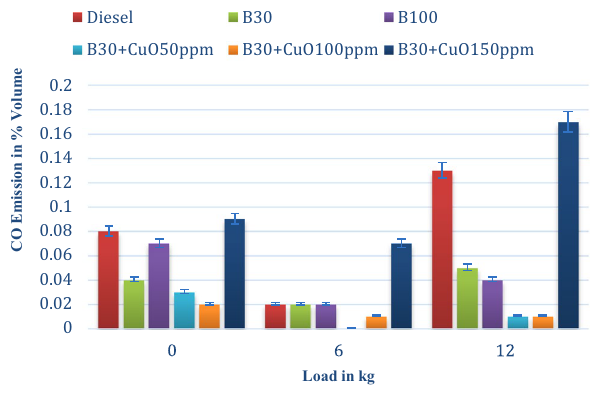
Fig. 3 Effect of Load on CO emission in % of blends consisting die- sel and WCO biodiesel with CuO nanodopes